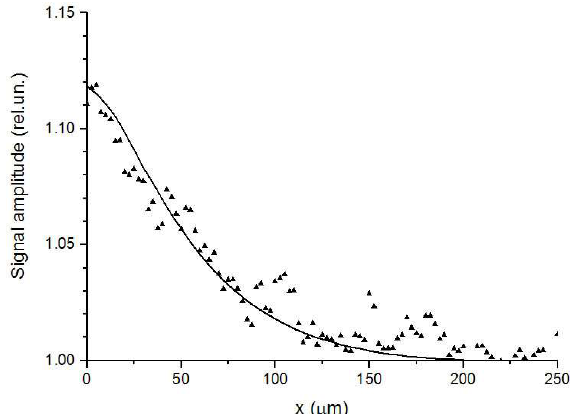
Figure 9. The PBD signal amplitude versus the distance from the Si–Al interface. Triangles are for the experimental data for the sample with the joint thickness of 15 µ m bonded under the pressure of 5.5 kPa. The solid curve corresponds to the fitted thermal resistance 2.5 × 10 − 7 m 2 K/W. Adapted with permission from [58]. Copyright (2018),